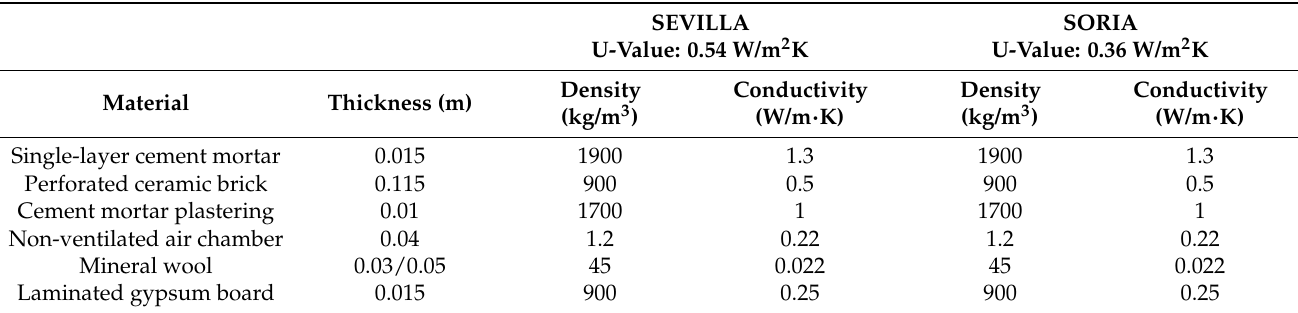
Table 3. Characteristics of the construction system in the flat Table 2. Characteristics of the construction system in the facade enclosure.